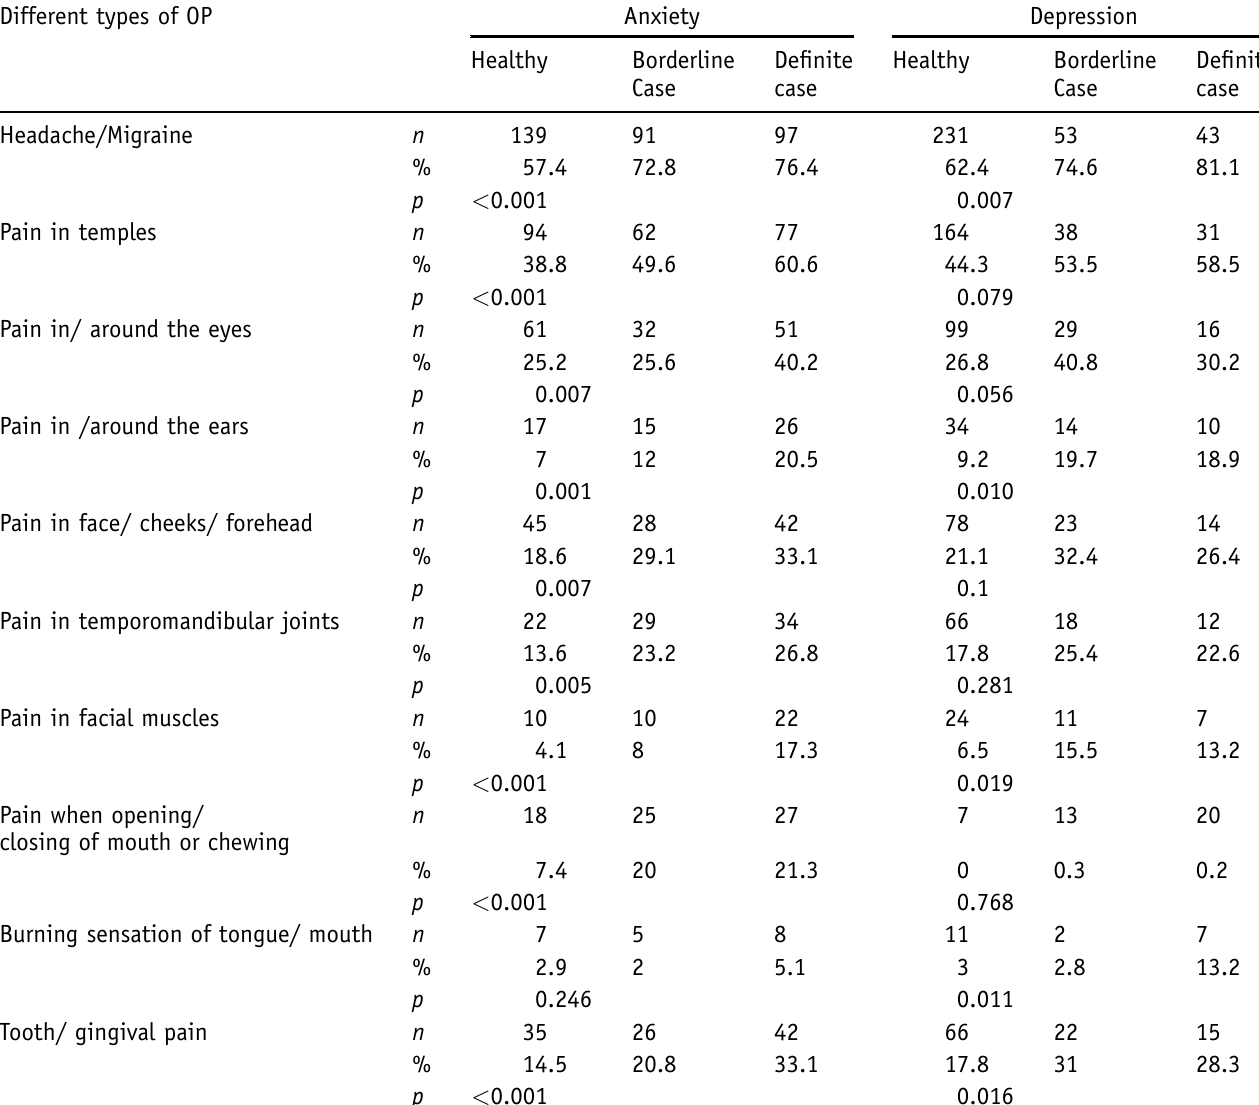
Table III. Association between anxiety and depression with different types of OP symptoms. Different types of